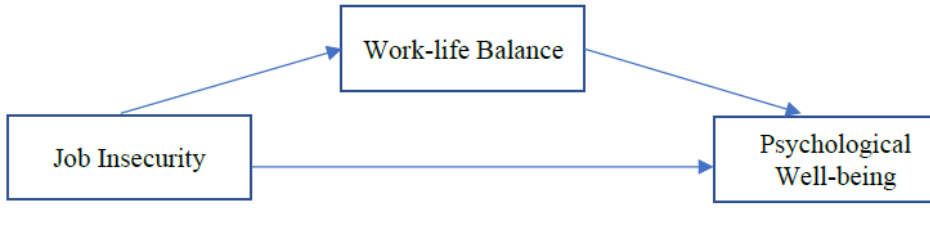
Figure 1. Focus of Current Study.